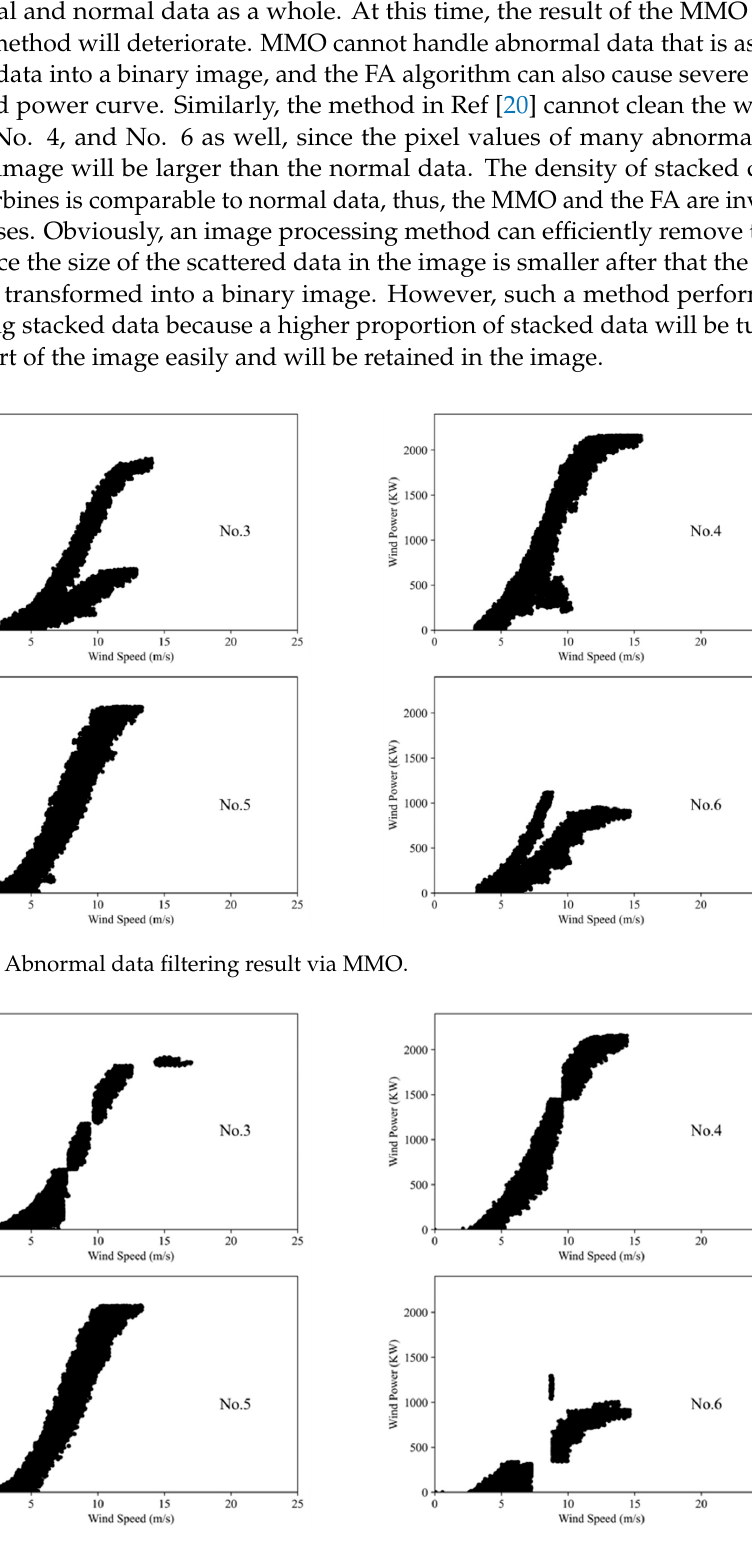
Figure 5. Abnormal data filtering result via QD.